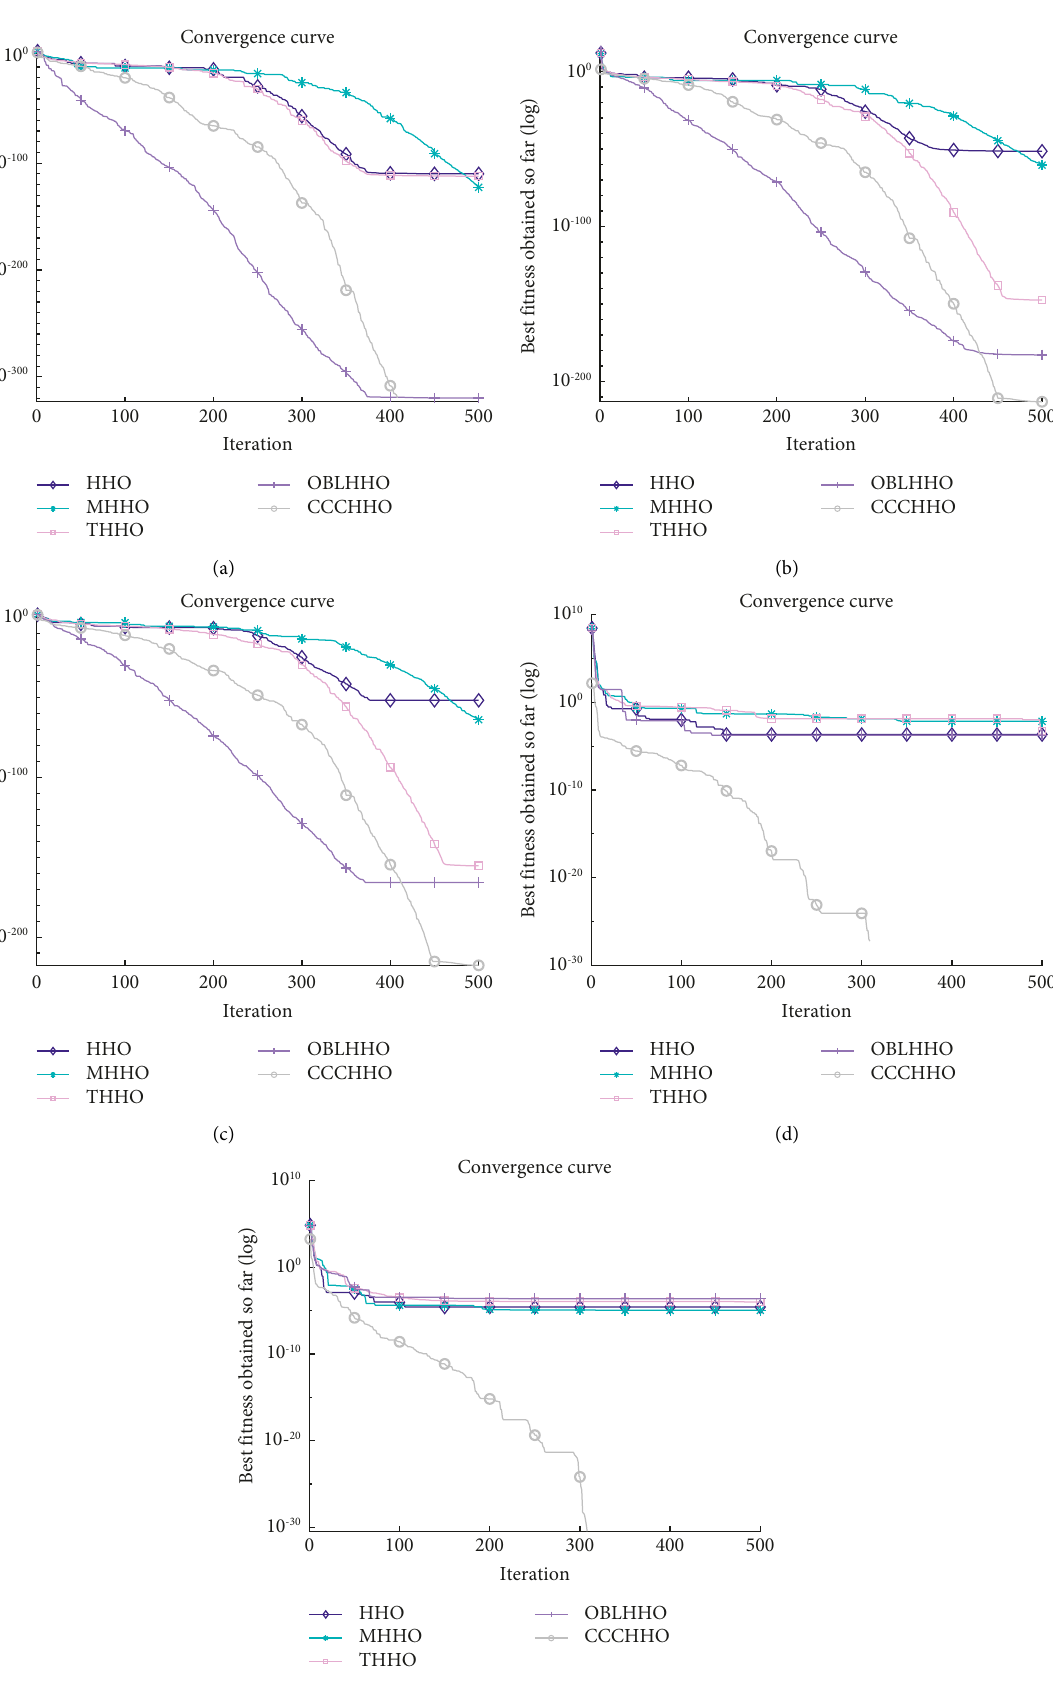
Figure 3: Convergence curve of unimodal function. (a) F1. (b) F2. (c) F3. (d) F4.(e)